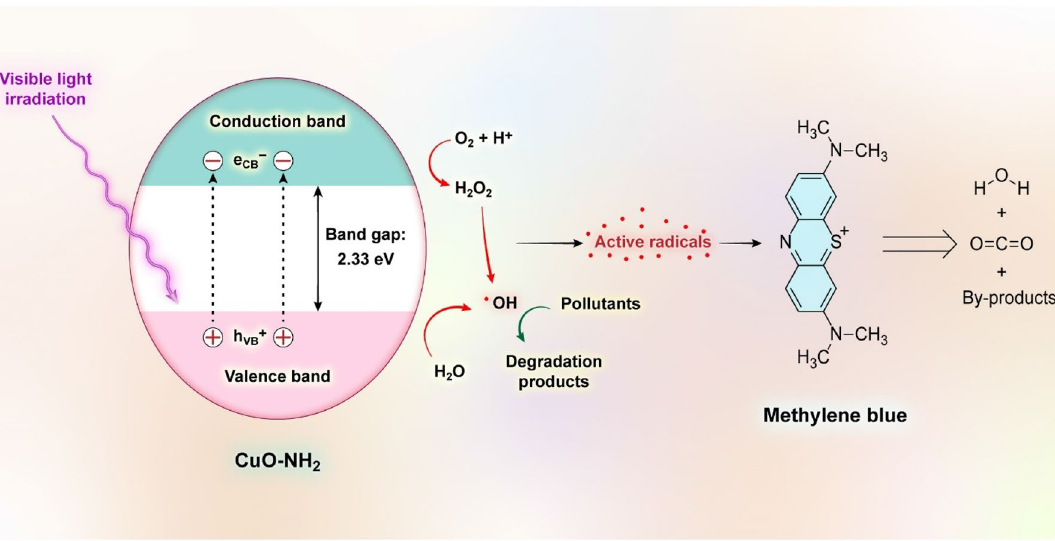
Figure 7. Schematic for the MB photodegradation